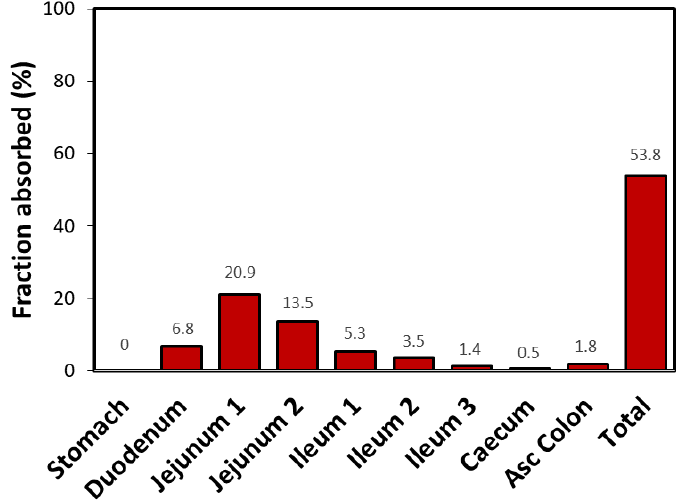
Figure 6. GastroPlus ® simulated regional absorption of furosemide following p.o. administration of 40 mg drug dose (the simulated values refer to the fraction of drug dose that entered into the enterocytes).